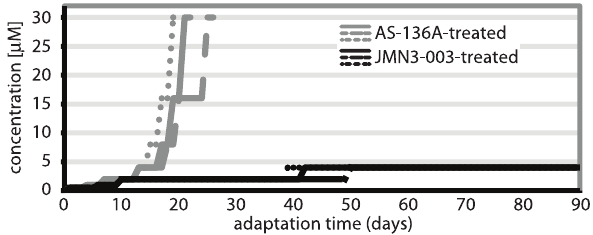
Figure 8. JMN3-003 prohibits rapid emergence of viral resistance invitro . MeV-Alaska remains sensitive to the compound after continued adaptation events for a 90-day period, while resistance (extensive viral CPE detectable in the presence of 30 m M compound) to pathogen-directed AS-136A emerges in step-wise adaptations after 15– 25 days. Three independent adaptations (represented by solid, dotted and dashed lines, respectively) were pursued for each compound.